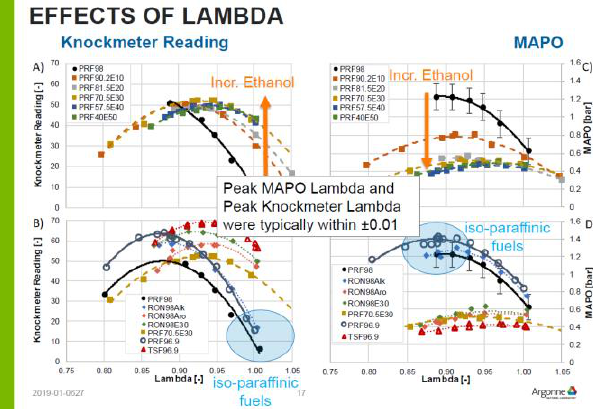
Fig. 11. Knock characterisation of a range of fuels for a range of lambda values [42] Dr. Tadeu Cordeiro de Melo (Petrobras, Brazil)